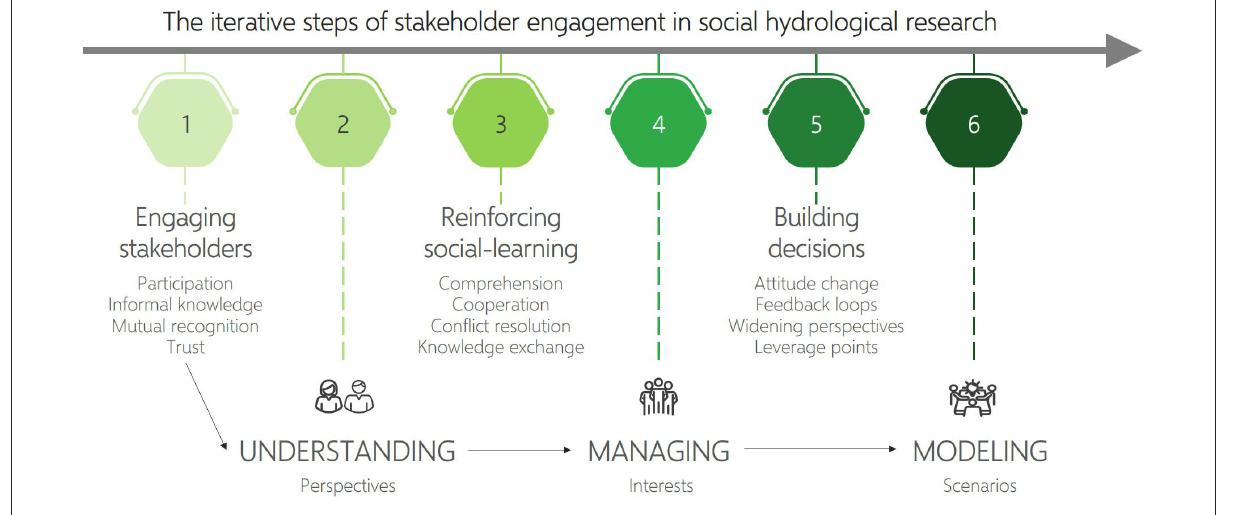
FIGURE1 The iterative steps of stakeholder engagement in social hydrological